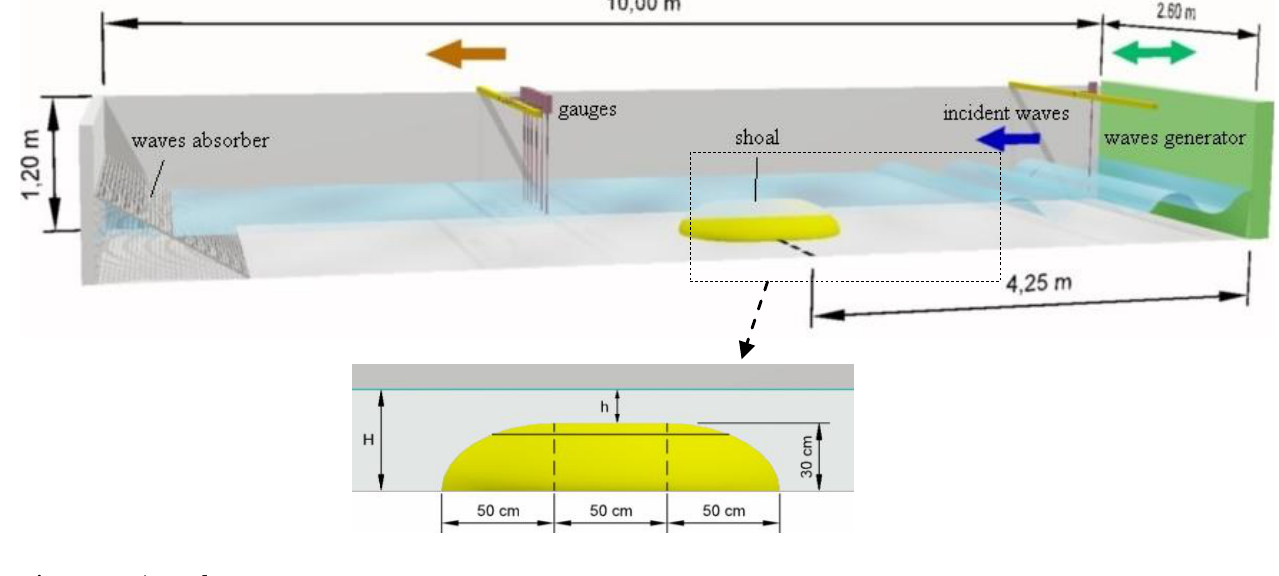
Fig. 1. Experimental set-up.